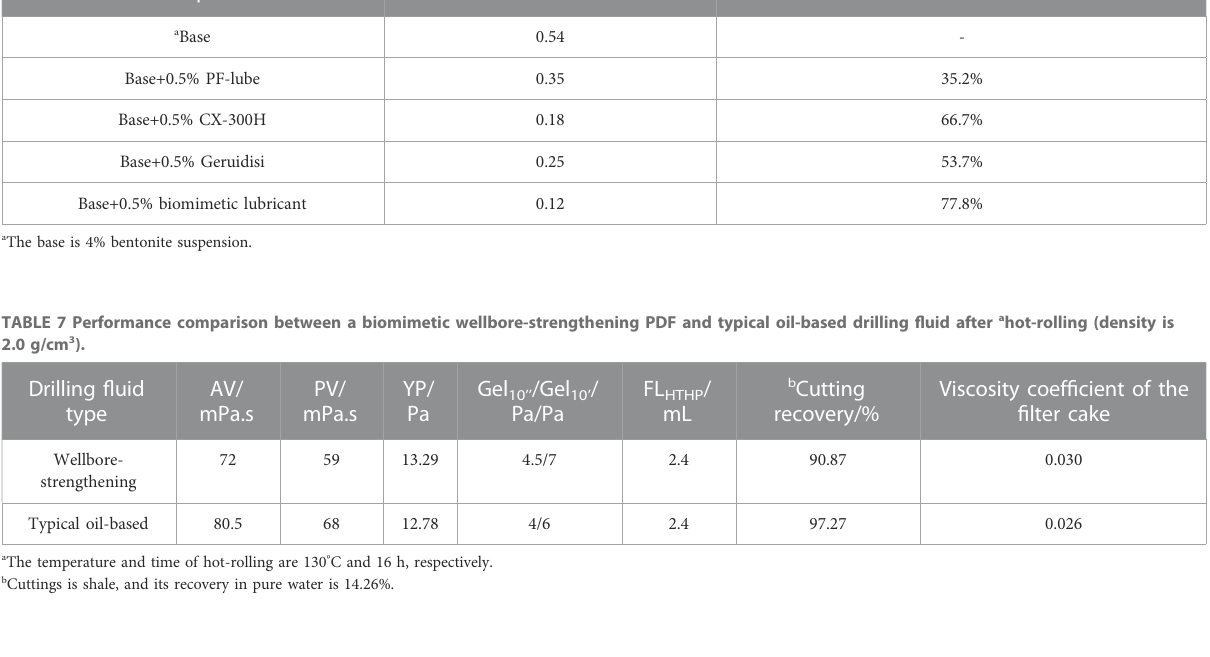
TABLE 6 Lubricity comparison between a biomimetic lubricant and other high-performance lubricants. Sample